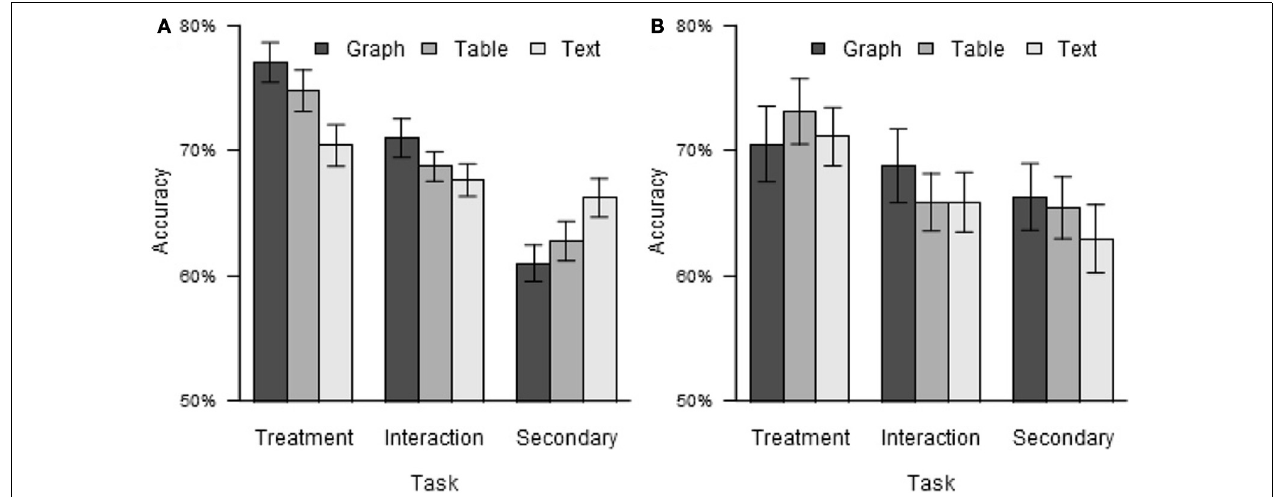
FIGURE 2 | Test accuracy by task and format. (A) Experiment 1. (B) Experiment 2. Error bars indicate standard errors, here and elsewhere.